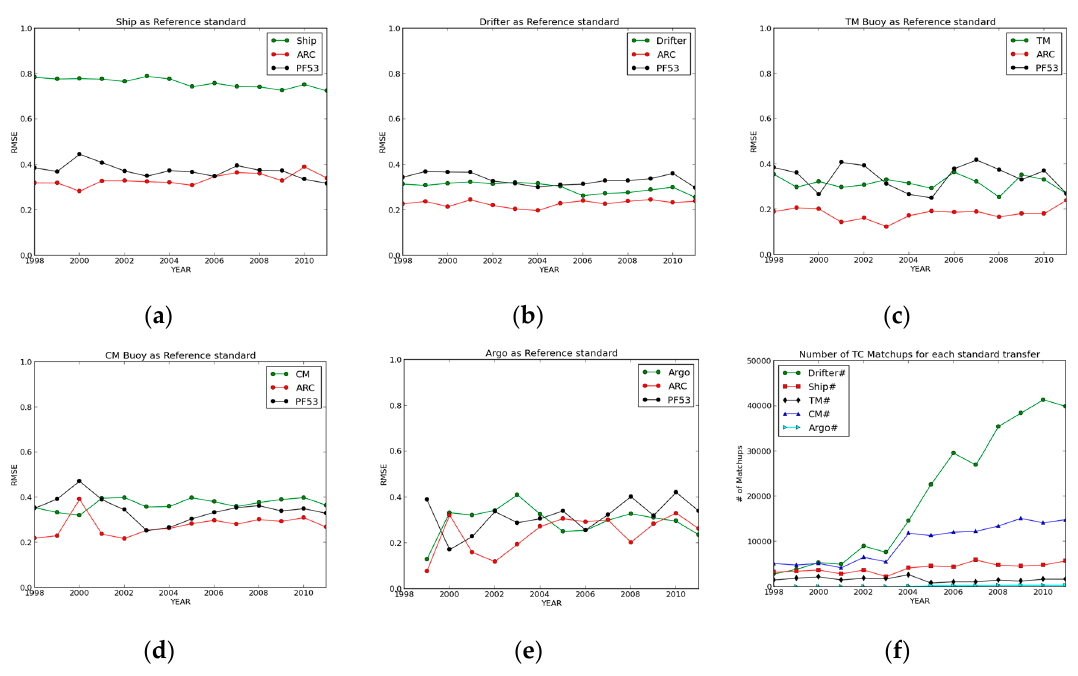
( b ) Figure 2. ( a ) nighttime bivariate plot between the PF53-Drifter and ARC-Drifters and ( b ) daytime bivariate plot between the PF53-Drifter and ARC-Drifters. 4.3. Triple Collocation In an attempt to understand the true noise associated with different products, we have employed the extended triple collocation method to perform a three-way error analysis. The matchup databases developed here are used to create appropriate triplets, as described in Section 2. These matchup numbers decrease to tens of thousands to thousands when the triple collocation is applied to compare the ARC and PF53 data. For all these statistics, only the best quality (QF = 5) PF53 data is used. Figure 3a–e shows RMSEs of ARC, PF53, and in situ data derived from the triple collocation between the three datasets for nighttime only. For each combination, in situ data (drifters, ship, tropical moorings, coastal moorings, and Argo floats) is the transfer comparison standard (reference). With drifters as in situ transfer standards, the RMSE ranges from 0.29 to 0.37 K for PF53, 0.25 to 0.32 K for drifters,